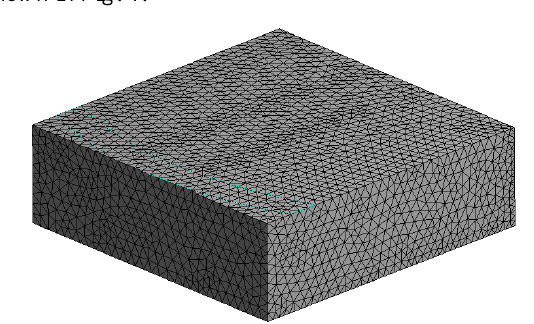
Fig. 4. Finite element mesh.